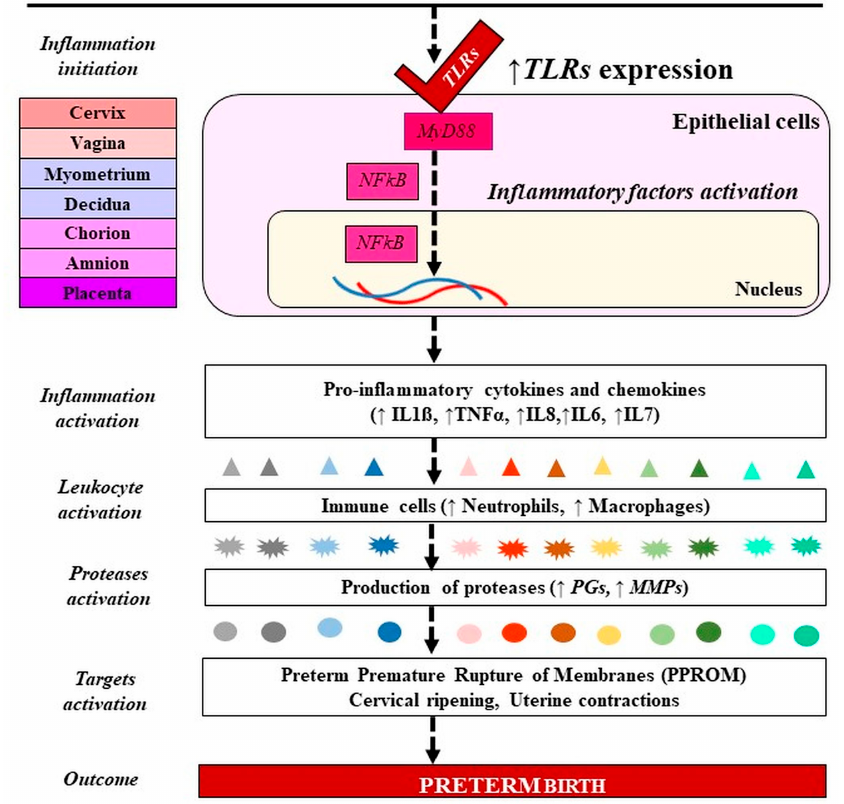
Figure 4. Molecular mechanism of microbiota-metabolites in preterm birth. Signaling of PAMPs and DAMPs derived from gut microbiota and dietary molecules have activated TLRs in PTB. The blue and gray colors refer to carbohydrates, the red color refers to proteins, the yellow color refers to lipids, and the green color refers to vitamins. From dark color to light color indicate metabolites forms and their generated inflammatory markers. PAMPs: Ppathogen-associated molecular patterns, DAMPs: Damage-associated molecular patterns; VD: Vitamin D; 25D: 25-hydroxy vitamin D; 1,25(OH)2D3: 1 α ,25-dihydroxy vitamin D. TMA: Trimethylamine, TMAO: Trimethylamine N-oxide; IL: Interleukin; TNF: Tumor necrosis factor; MMP: Matrix metalloproteinase; PGs: Prostaglandins. TLRs : Toll like receptors. Dashed lines indicate several steps, ↓ decreased, ↑ increased